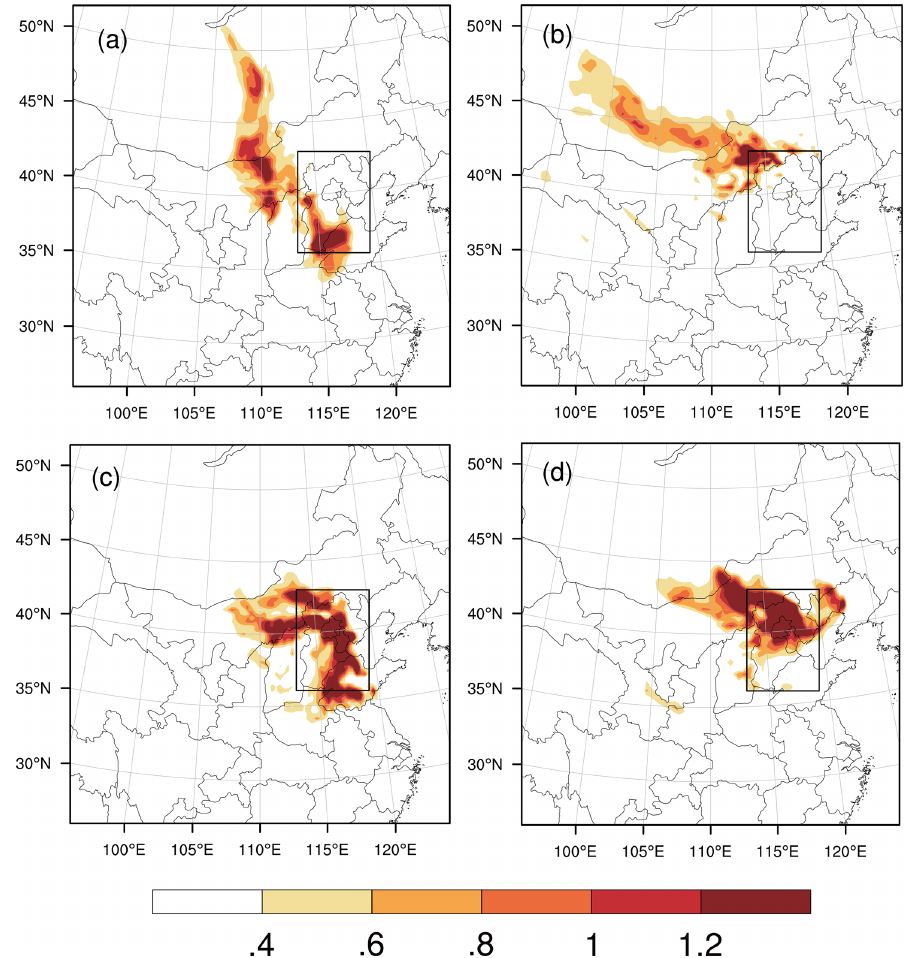
Figure 7. The horizontal distribution of the VI (Jkg − 1 ) for the forecasts at the AT with lead times of (a) 24h and (c) 12h and for the forecasts at the DT with lead times of (b) 24h and (d) 12h. The black rectangle is the verification